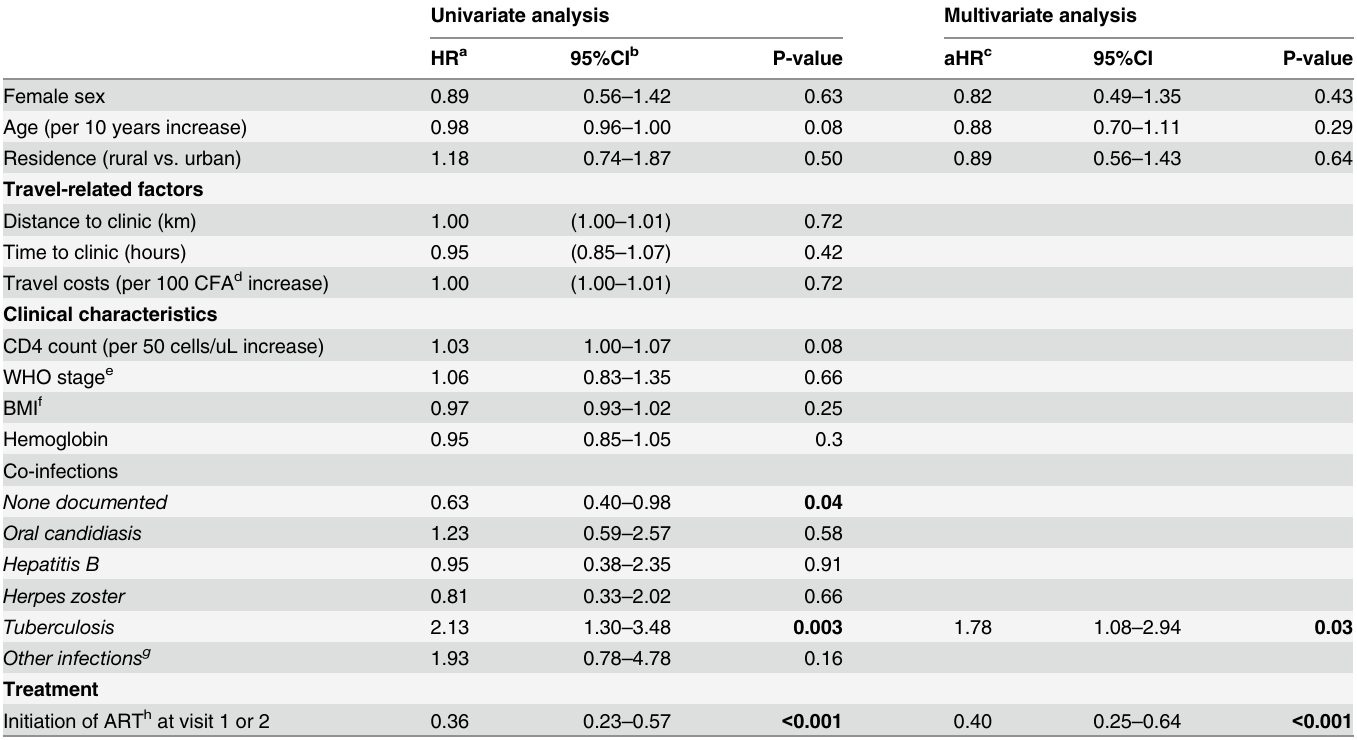
Table 2. Factors relating to loss to follow up among adult non-pregnant HIV-patients, attending the primary HIV clinic in Lambaréné, Gabon, between January 2010 and January